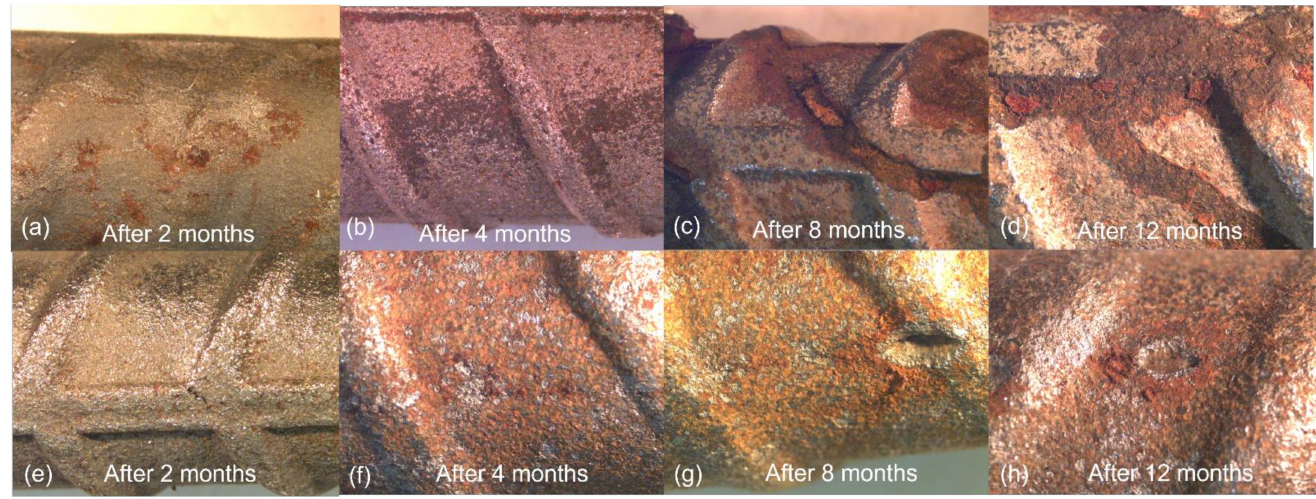
Figure 10. Surface morphology of rebars after 2, 4, 8, and 12 months of immersion: ( a – d ) 615; ( e – h ) 9% Cr